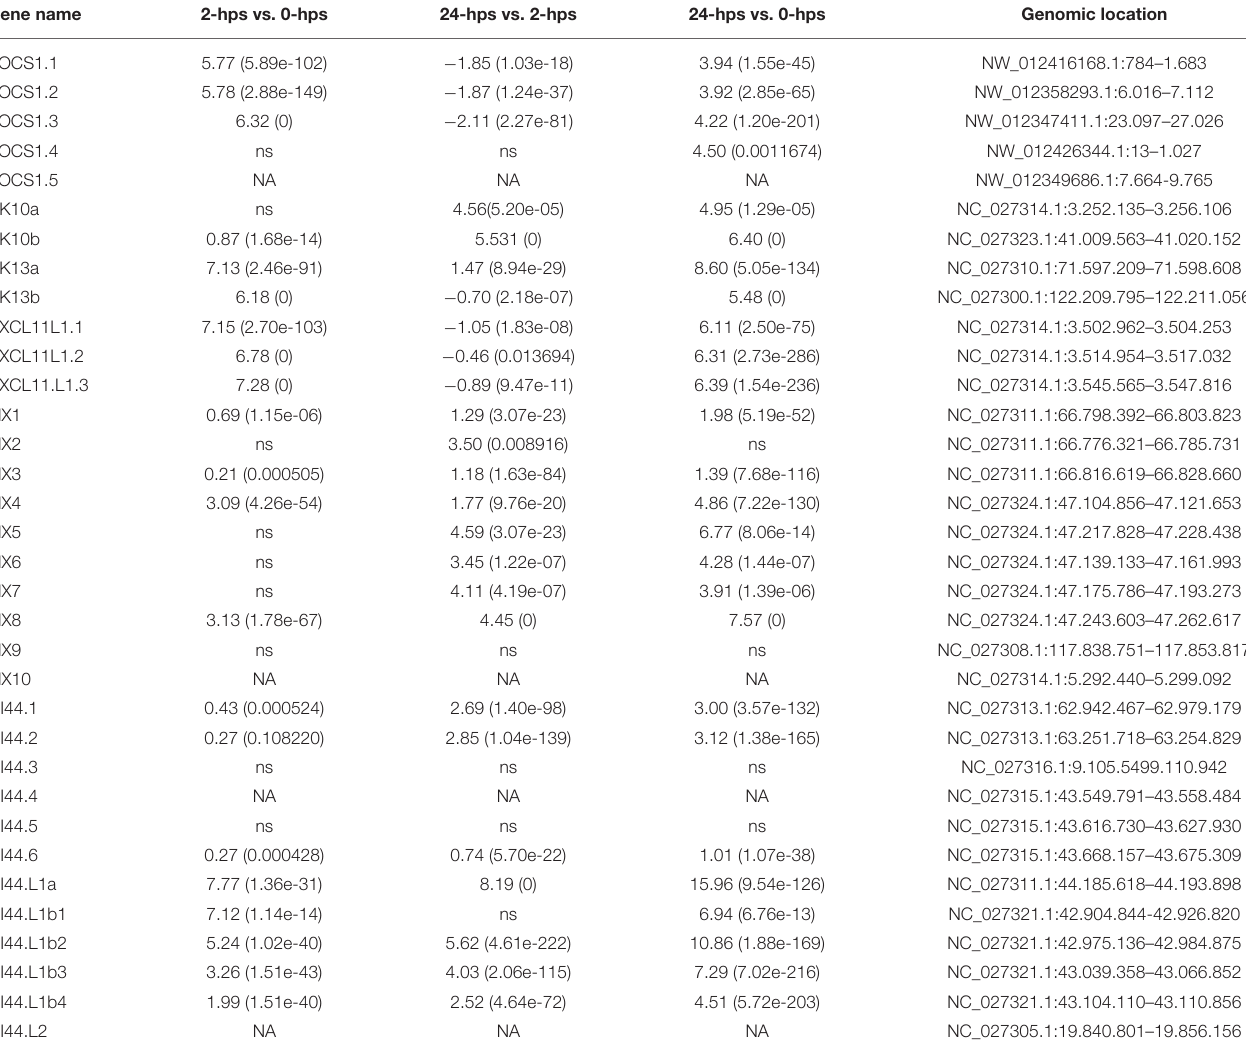
TABLE 2 | Log 2 fold change with adjusted P -values for selected first line of defense